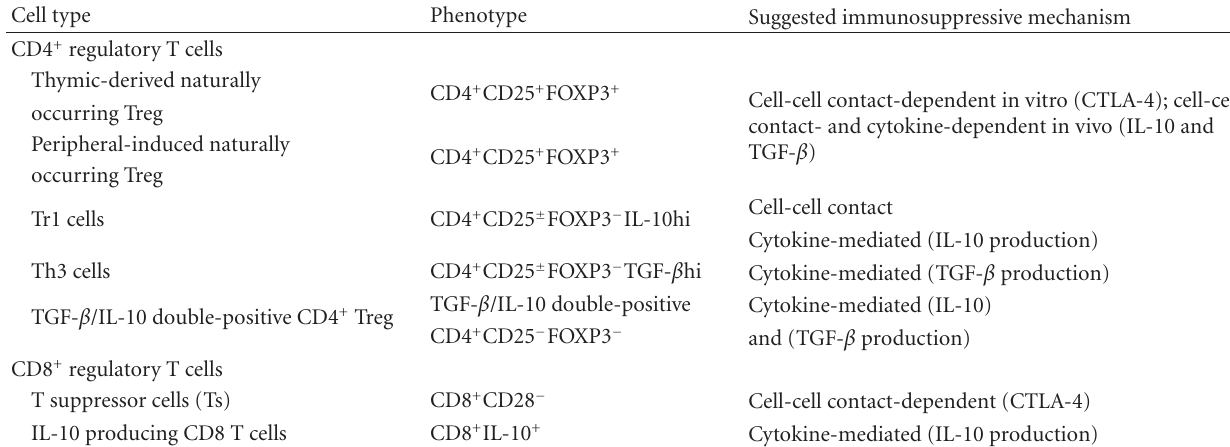
Table 1: Di ff erent subsets of regulatory T